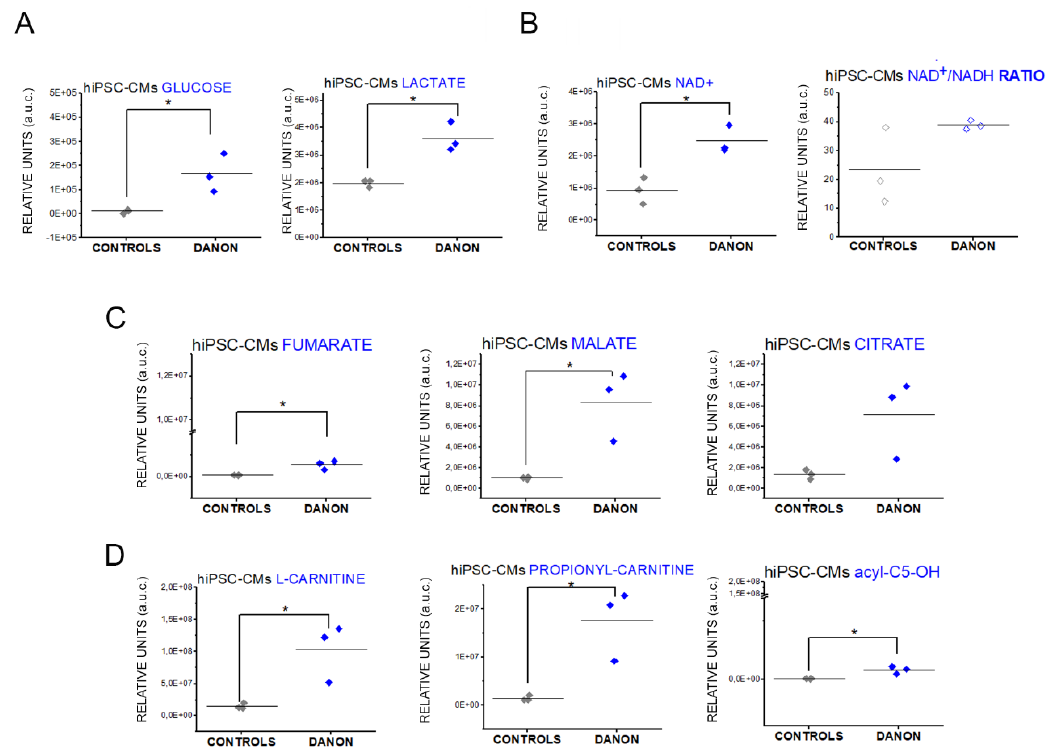
Figure 3. Metabolome profiling of hiPSC-CMs. ( A ) Effect on intracellular glucose level (13.26 fold changes increase) and on intracellular lactate, NAD+ and NAD+/NADH ratio ( B ) TCA cycle ( C , fold changes increase: fumarate 7.8; malate 9.19; citrate 6.37) and fatty acids ( D , fold changes increase: L- carnitine 9.45; propionyl-carnitine 18.51; acyl-C5-OH 13.06). * Significant difference p < 0.05 t -test.